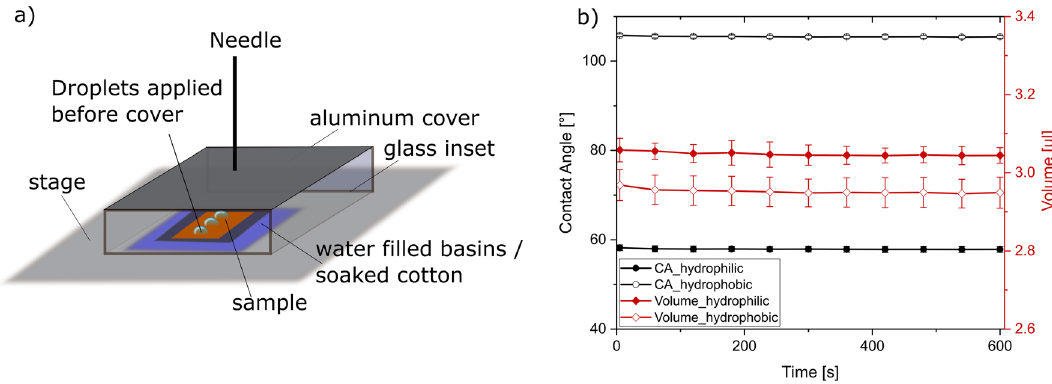
Figure 11. Schematic overview of the “cover”-setup ( a ). Change of the contact angle and the droplet volume, ( b ) over time with the designed setup ( a ). Each experiment was repeated three times on different samples.